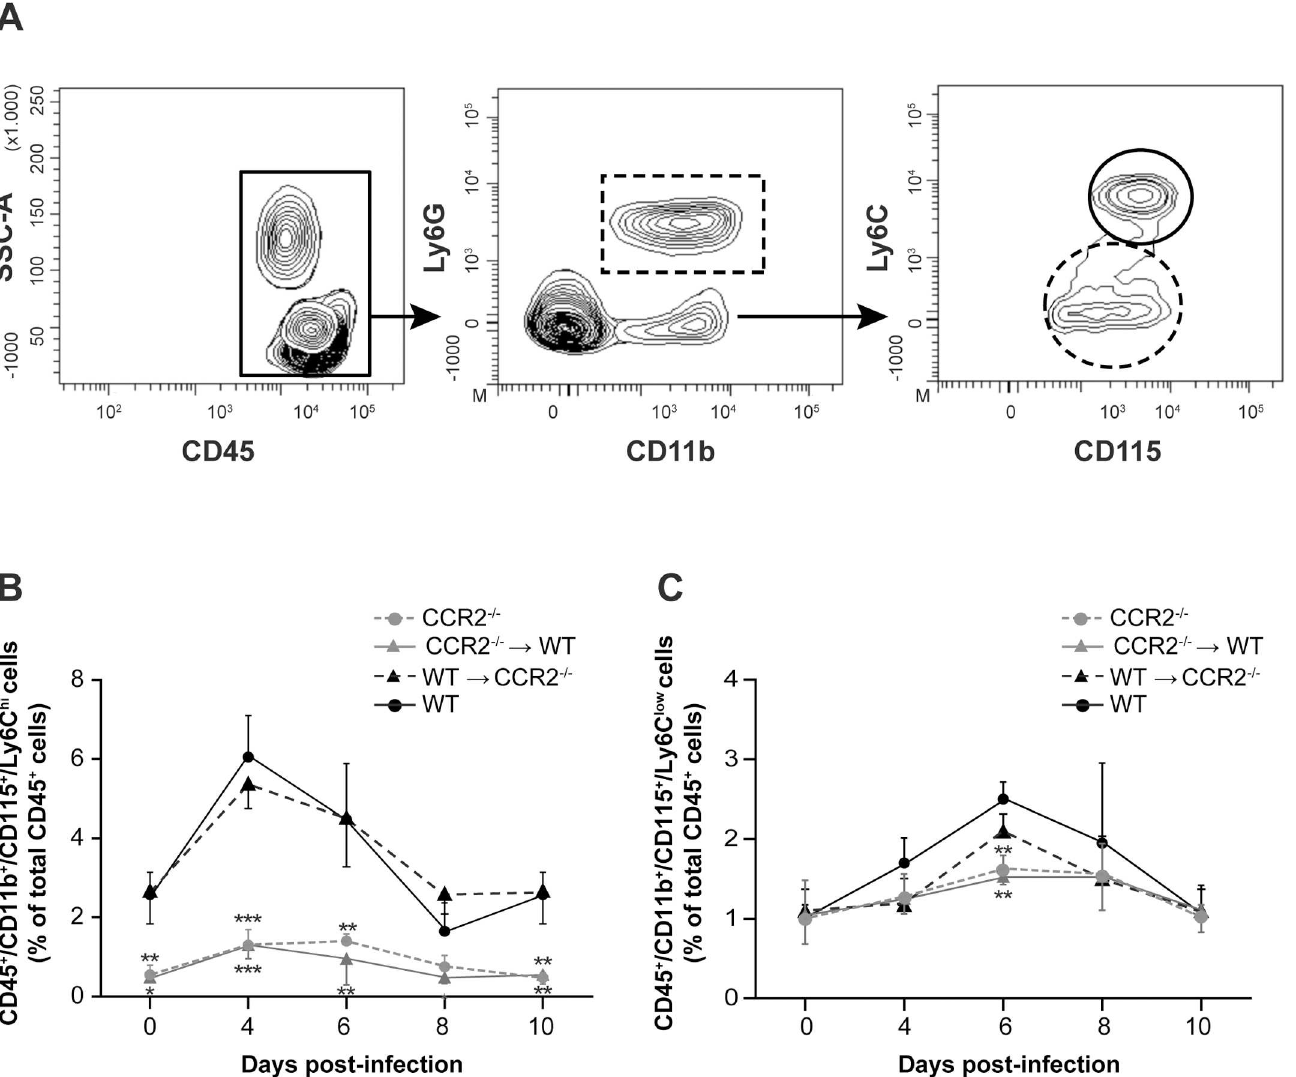
Fig 5. Impact of CCR2 deficiency in resident cells of the CNS or in the hematopoietic systemon blood monocytes mobilization during HSE. Blood leukocytes of wild-type(WT) C57BL/6, CCR2 -/- , CCR2 -/- ! WT and WT ! CCR2 -/- mice were analysedby flow cytometry prior to (day 0) and on days 4, 6, 8 and 10 followingintranasal infectionwith 1.2x10 6 PFU of HSV-1. (A) Representative flow cytometry contour plots showingthe gating strategy for bloodleukocytes (i.e., CD45 + ) (continuous rectangle), granulocytes (CD45 + /CD11b + /Ly6G + ) (dashedrectangle), inflammatory monocytes (CD45 + /CD11b + /CD115 + /Ly6C hi ) (continuouscircle) and patrollingmonocytes(CD45 + /CD11b + /CD115 + /Ly6C low ) (dashedcircle). (B) Histograms illustratingthe percentage of inflammatory monocytes comparedto total leukocytes (CD45 + ), (C) histograms showingthe percentageof patrolling monocytes comparedto total leukocytes.Statistical analyseswere performed using a one-wayanalysisof variance(ANOVA) with Tukey’s multiple comparisonpost-test. Statistically significantresults comparedto those of the WT group are indicatedas follows: * , P < 0.05; ** , P < 0.01; *** , P < 0.001.